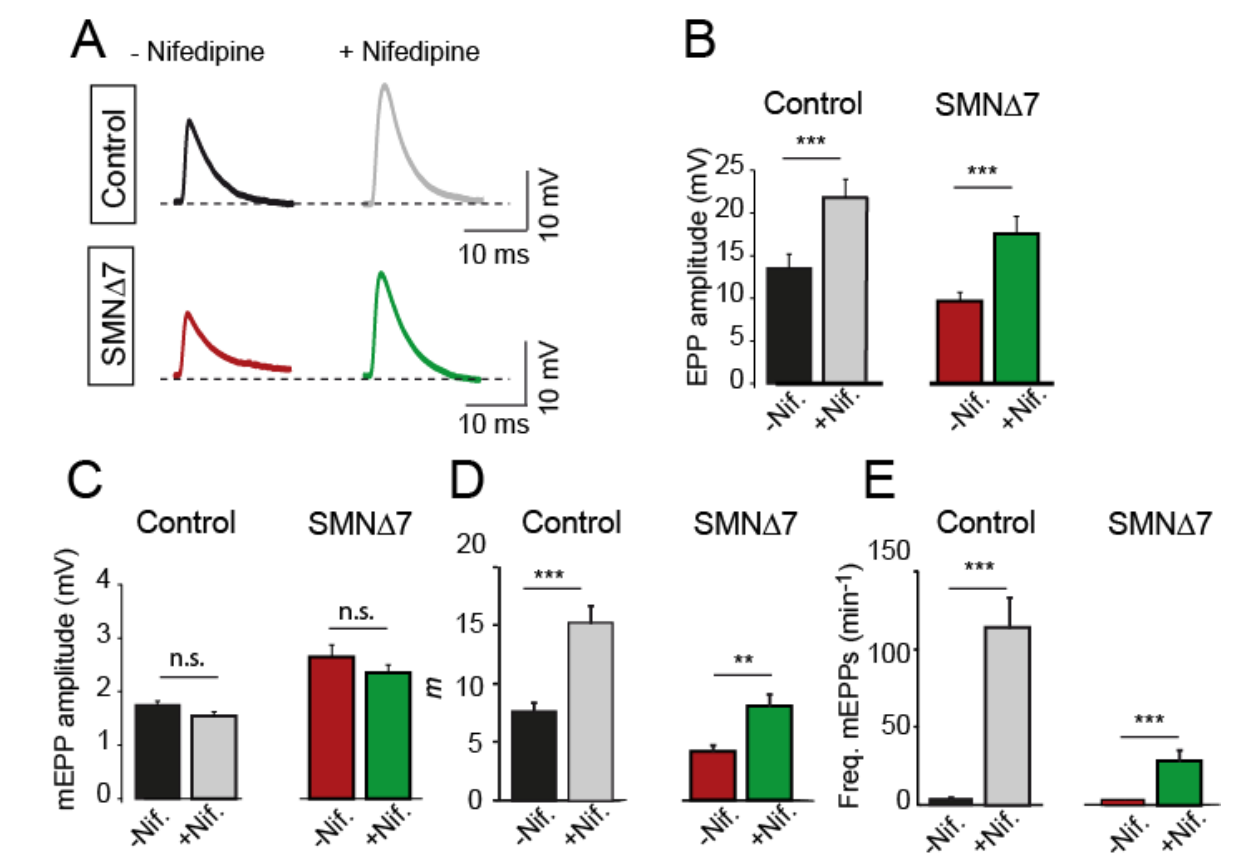
Figure 2. Secretion increases in the presence of nifedipine in motor nerve terminals from postnatal control and SMA mice. ( A ) Representative EPP recordings in the absence and the presence of nifedipine in control (top) and SMA (bottom) mice. ( B – E ) Mean EPP amplitudes ( B ), mEPP amplitudes ( C ), quantal content ( m ) ( D ), and mEPP frequencies ( E ) in the absence and presence of nifedipine in both genotypes. The numbers in the bars indicate the recorded fibers. N = 5 mice per genotype. Mann–Whitney U and two-tailed Student’s t (quantal content) -tests; *** p < 0.0005; ** p < 0.005.